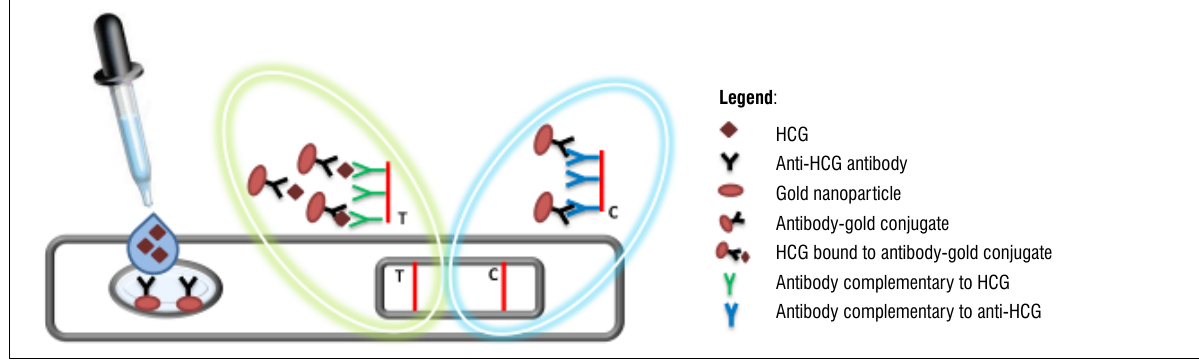
Illustration of a lateral flow pregnancy test. Urine is placed in the sample introduction window onto a sample pad. If the hormone human chorionic gonadotropin (HCG) is present in urine, it binds to a complementary anti-HCG antibody which is attached to a gold particle. The HCG-antibody- gold conjugate flows to meet a second antibody which is complementary to HCG, resulting in the stripe at the test line (T). Antibody-gold conjugates that do not bind to HCG flow to a third complementary antibody, resulting in a stripe at the control line (C). A positive pregnancy result occurs when both the test and control lines are observed, a negative result occurs when the control line is observed